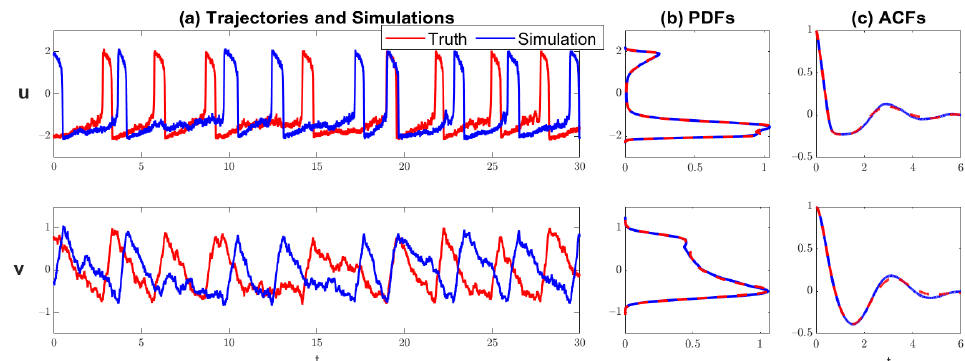
Figure 6. Comparison of the models with the true parameters (dashed red curves) and with the estimated parameters (solid blue curve) for dynamical regime 1. The last point in each of the trace plots is regarded as the estimated value of each parameter. ( a ) the comparison of the trajectories. Note that the trajectories are computed with different random noise seeds in the two runs. Therefore, the trajectories are not expected to be point-wise consistent with each other; ( b , c ) the comparisons of the PDFs and the ACFs.